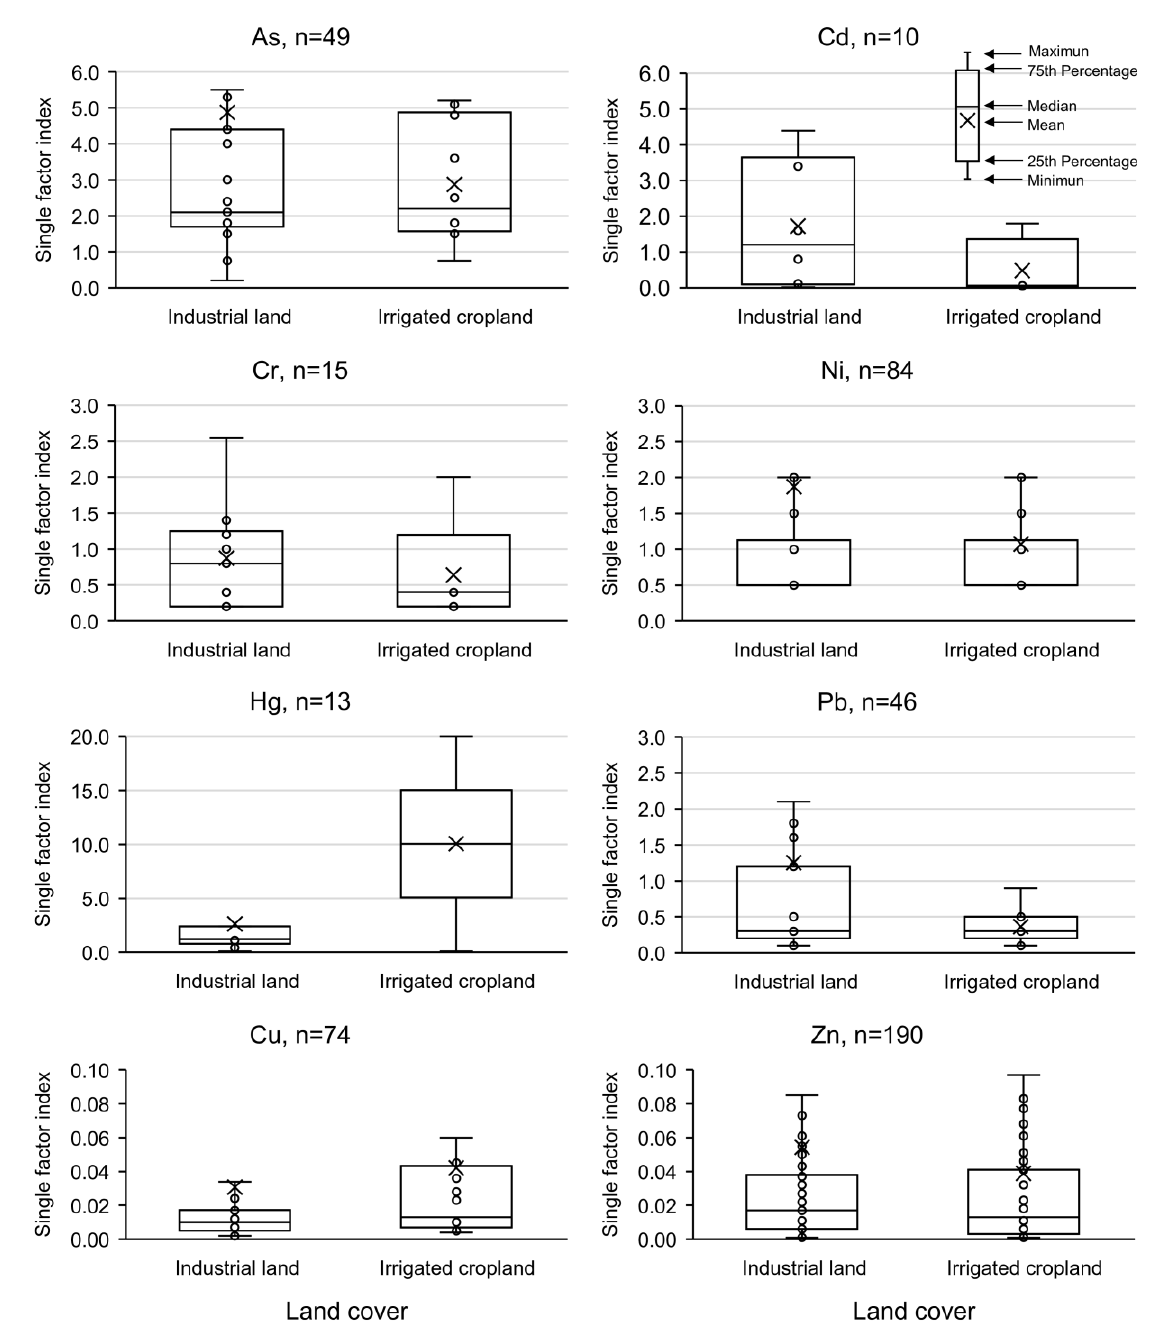
Figure 3. The single factor index box-plot of heavy metals in two land types (industrial land and irrigated cropland), n represents the number of sampling points that exceeded the detection line.